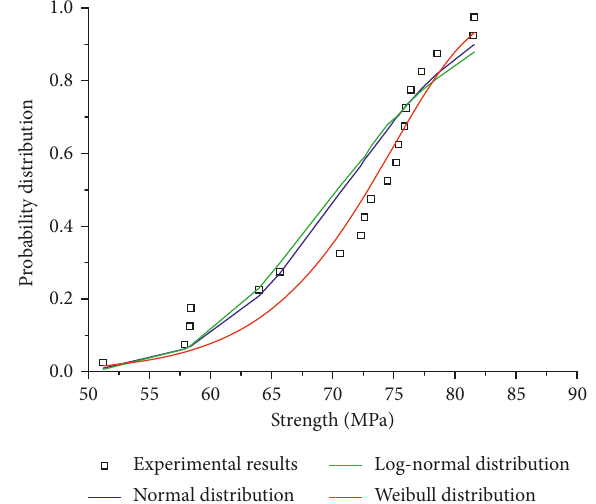
Figure 4: Probability distribution characteristic of the strength under compression.